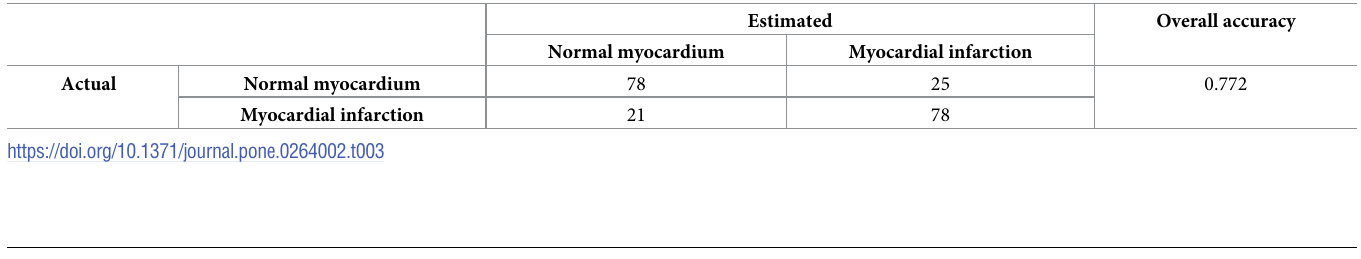
Table 3. Overall classification accuracy of the artificial neural network for the long-axis view